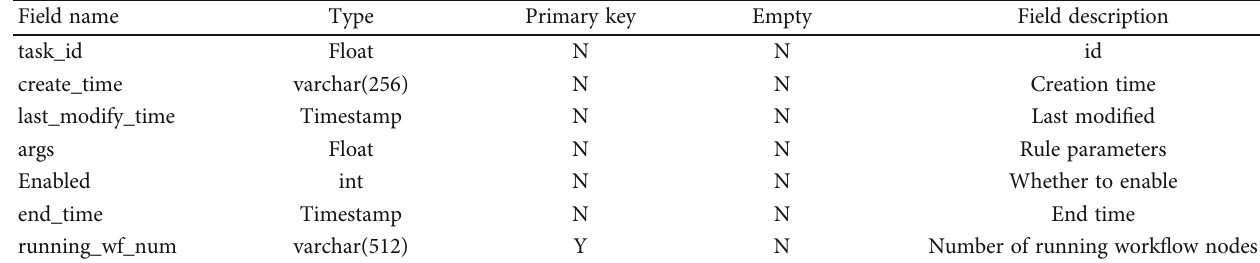
Table 3: Data integration task